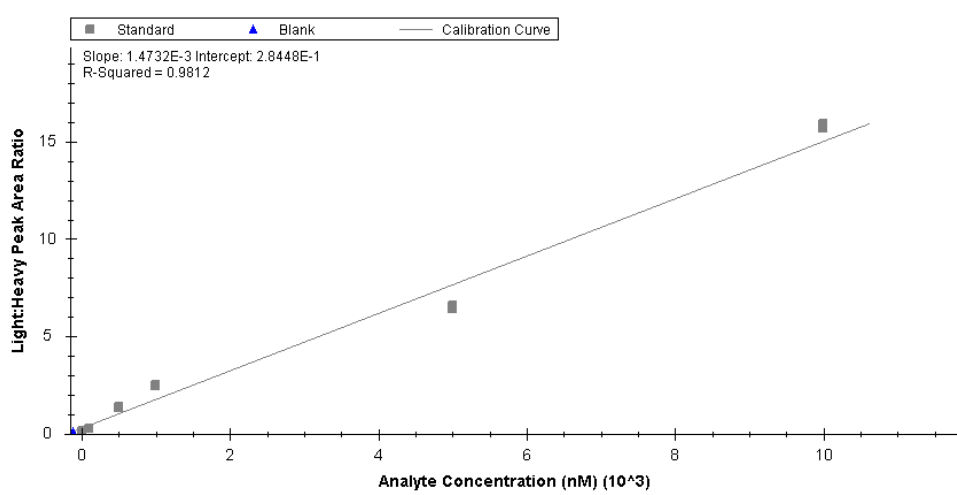
Figure A1. Triglycerides (TG) 54:6 label-free quantification using external calibration (n = 3).